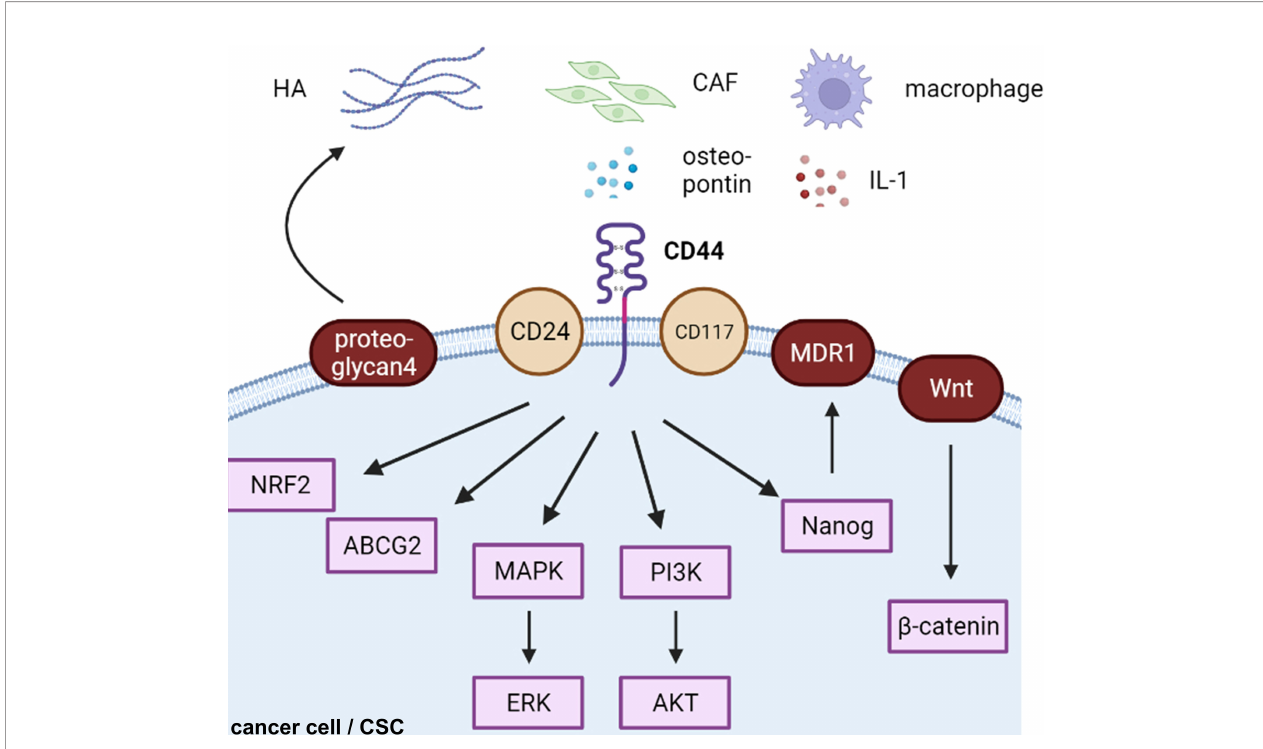
FIGURE 2 | CD44-related cascades in cancer cells. HA, hyaluronic acid; CAF, cancer-associated fi broblast; CSC, cancer stem